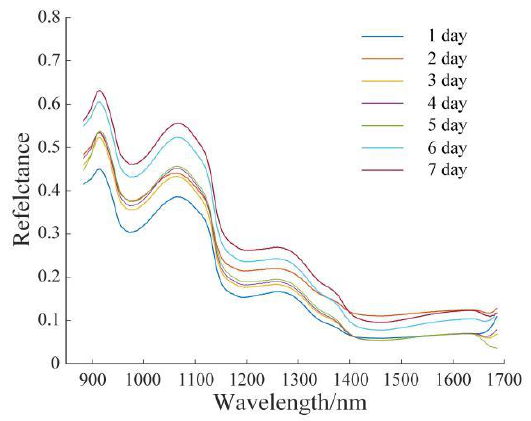
Figure 4. Average spectral curve.